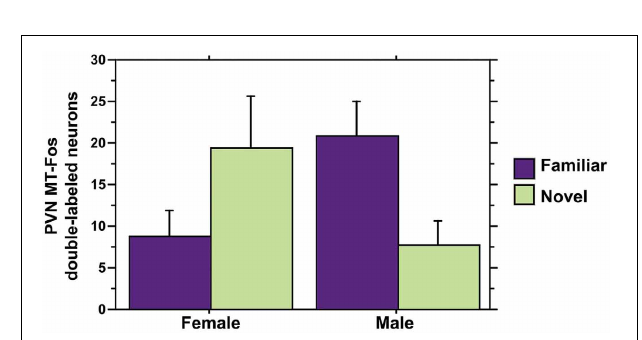
FIGURE 7 | MT-Fos double-labeled neurons in the PVN as a function of an interaction between Sex and Context. A strong Sex × Context interaction is observed in an ANCOVA model for PVN MT-Fos double-labeled neurons with Behavioral PC1 (Social competence/dominance) as a covariate. F ( 1 , 32 ) = 8 . 04, p < 0 . 01. A nearly identical result is obtained with the covariate of Behavioral PC3 (Anxiety); see Results. Data are shown as means + SEM.